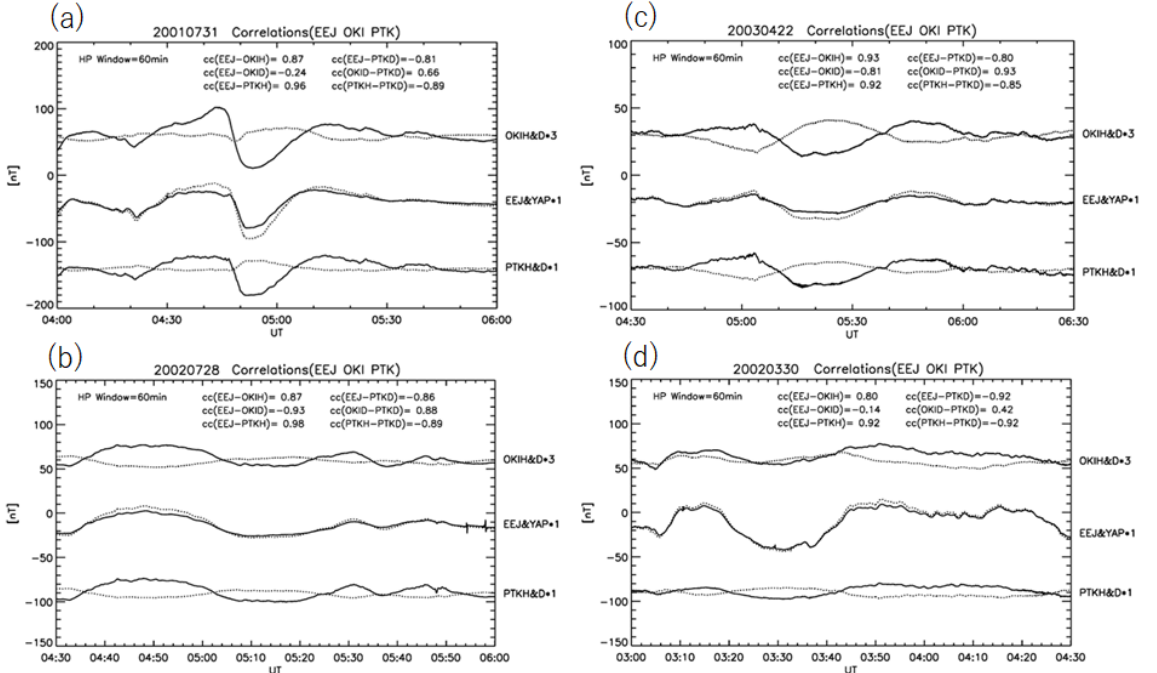
Figure 4. DP2 magnetic perturbations recorded in the afternoon (1330–1730 MLT). The format is the same as in Figure 1. ( a – d ) are used for reference in the text.